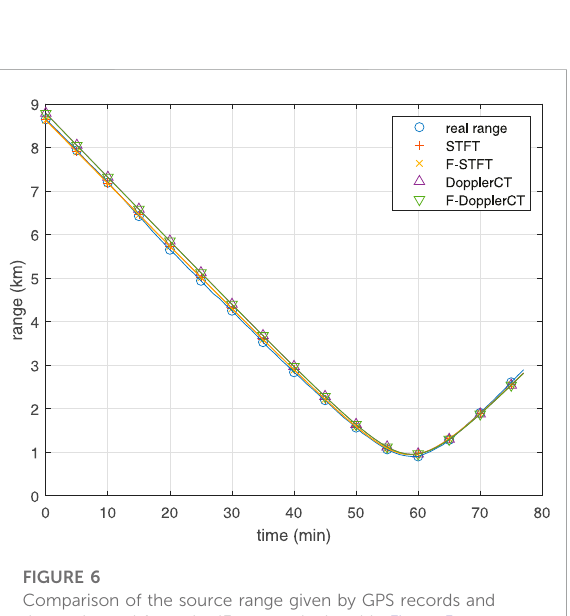
FIGURE 6 Comparison of the source range given by GPS records and that estimated from the IF curves depicted in Figure